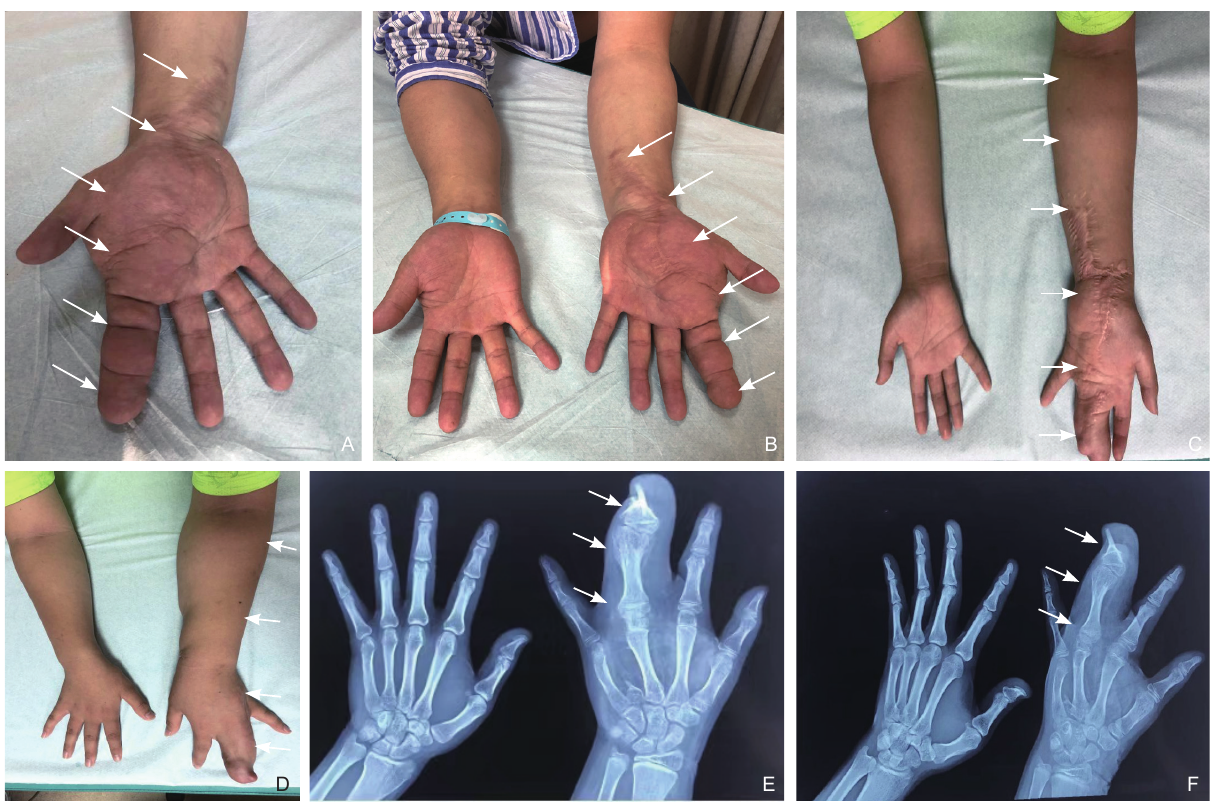
Figure 1 (A-B) Photograph of wrist and hand of a patient with lipomatosis of median nerve, showing the neoplasms from the distal forearm to the wrist and palm, accompanied by the macrodactyly of index finger (arrow); (C-D) Photograph of wrists and hands of a patient with lipomatosis of median nerve and ulnar nerve, showing the neoplasms from forearm to the wrist and palm, accompanied by the syndactyly of middle and ring fingers (arrow); (E-F) Radiograph of hands of the same patient in (B), showing phalanx fusion of middle finger and ring finger of left hand, manifested as syndactyly (arrow).